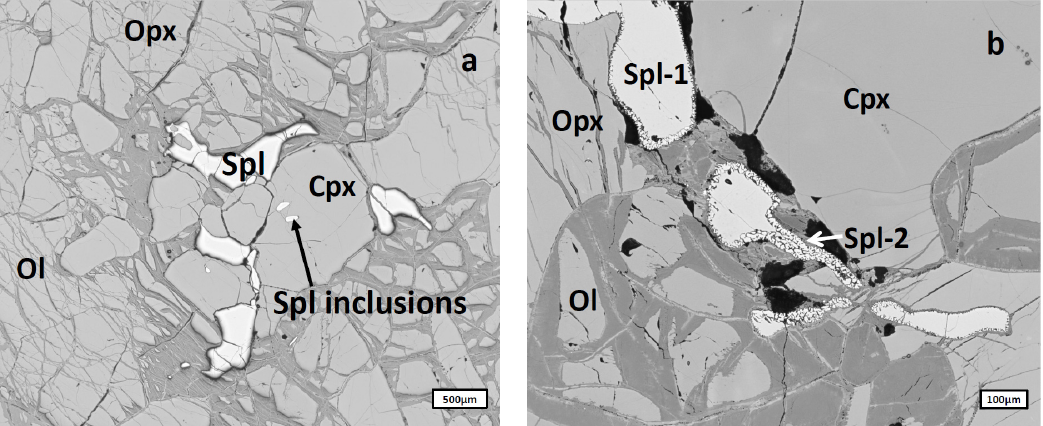
Figure 3. Types of spinels from Cpx-poor Spl lherzolites: ( a ), Primary spinel represented by clean homogeneous grains (Spl) and small oval spinel inclusions (Spl inclusions) in primary clinopyroxene; ( b ), Primary spinel grains (Spl-1) surrounded by a sporadic thin rim of secondary spinel (Spl-2). Cpx, clinopyroxene; Ol, olivine; Opx, orthopyroxene.